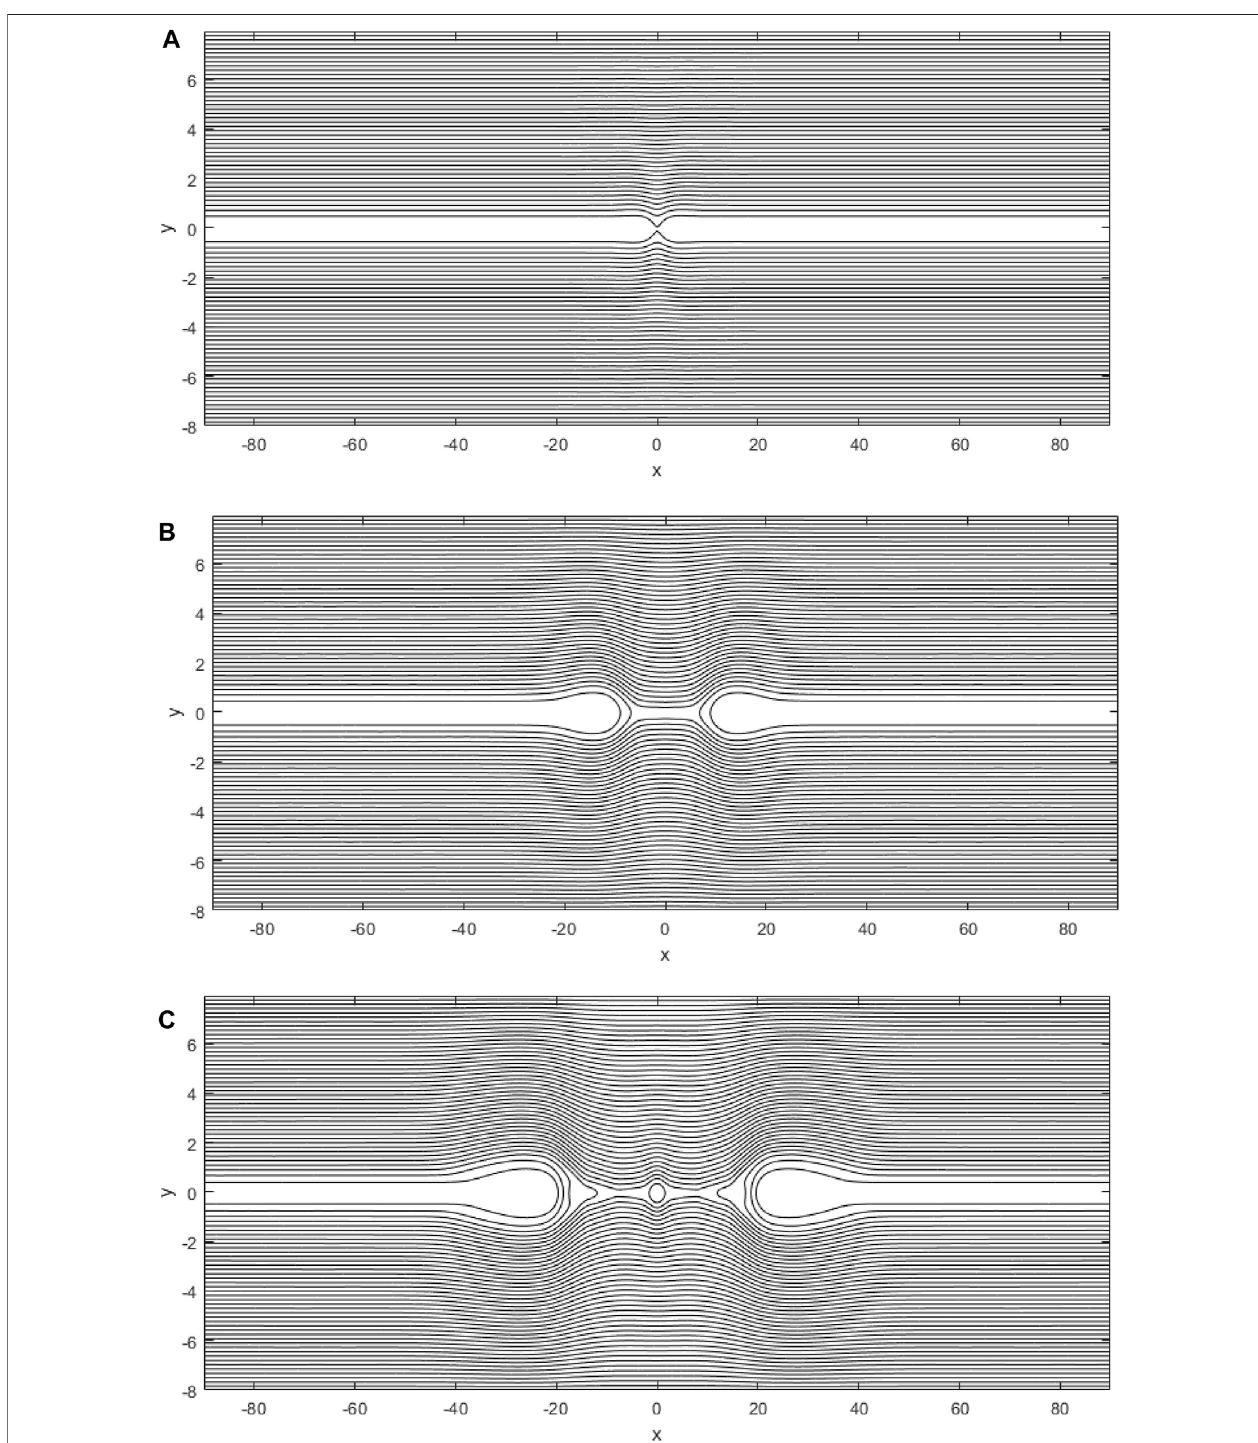
FIGURE 2 | Magnetic fi eld lines at different times of plasmoid instability for β (cid:1) 0.2. (A) : t (cid:1) 5, (B) : t (cid:1) 30, (C) : t (cid:1) 50, (D) : t (cid:1) 65 and (E) : t (cid:1) 85, (F) : t (cid:1) 105.